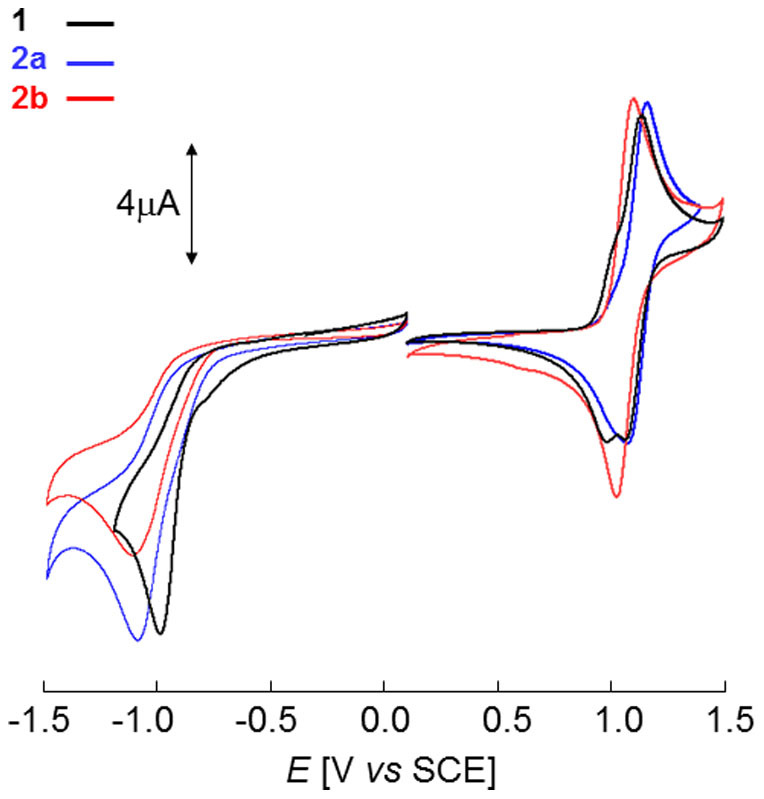
Cyclic voltammograms of compounds 1, 2a and 2b in 0.10 M Bu4NPF6/CH2Cl2, platinum electrodes, scan rate 100 mV cm−1.